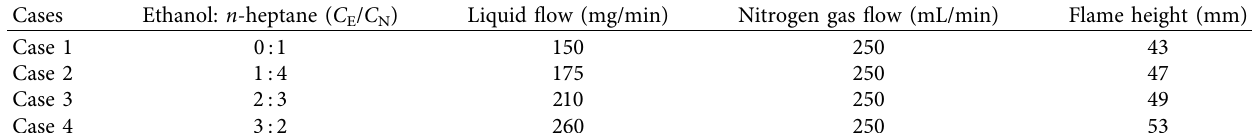
Table 1: Experimental conditions under different equivalence ratios of ethanol/ n- heptane.